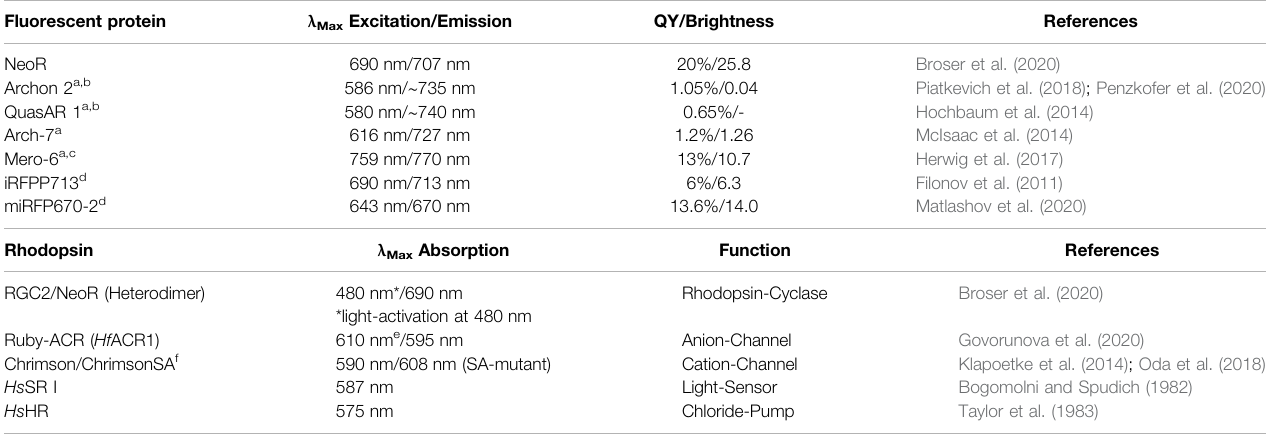
TABLE 1 | (Upper panel) Fluorescence properties of selected rhodopsin and phytochrome derived NIR fl uorescent proteins. (Lower panel) Optical properties of natural red- absorbing microbial rhodopsins. Fluorescent protein